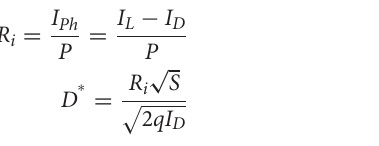
Figure 3A is the R i diagram of the DSM/PbPc devices.